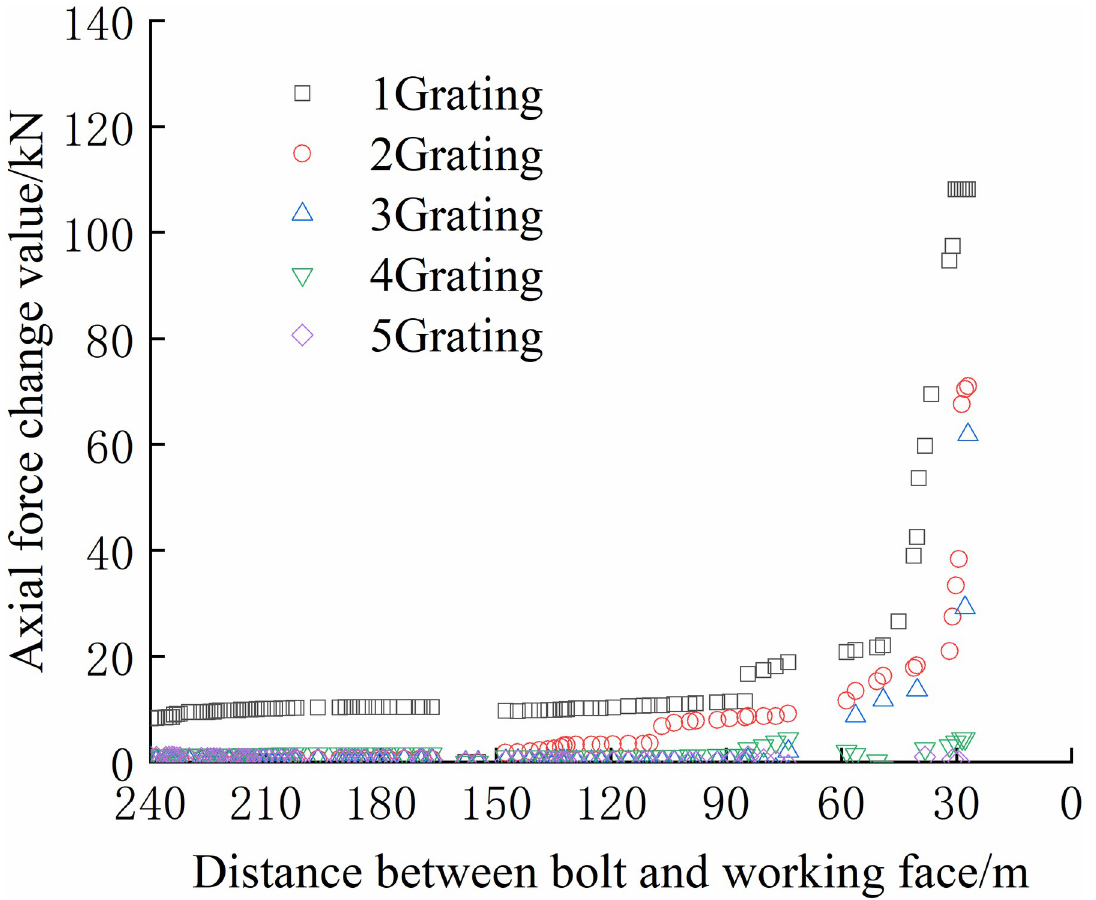
Fig 25. Axial stress monitoring test curve of No.2 bolt.